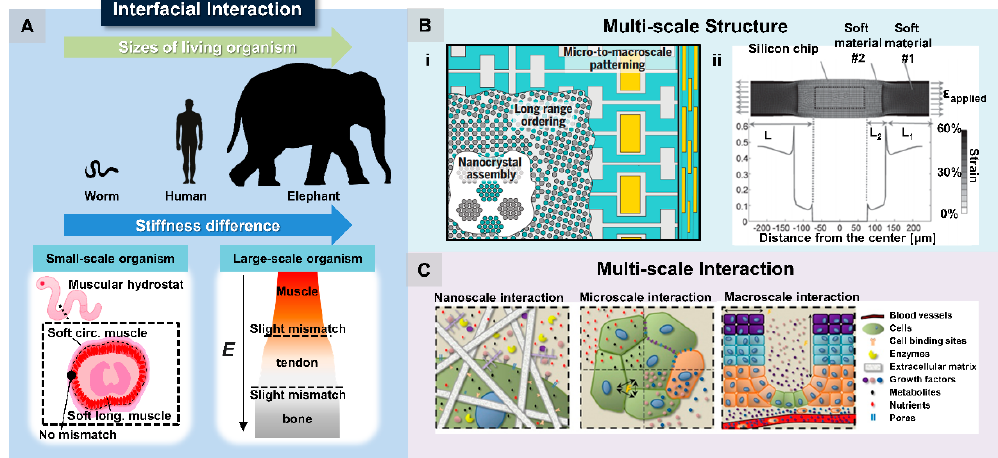
Figure 3. ( A ) Schematics of how the sizes matter interfacial interaction in living organisms. ( B ) Synthetic multi-scale structure for alleviating physical stress concentration due to mechanical mismatch. ( B , i ) Approach to bridging functional nanocomposites for constructing robust inorganic